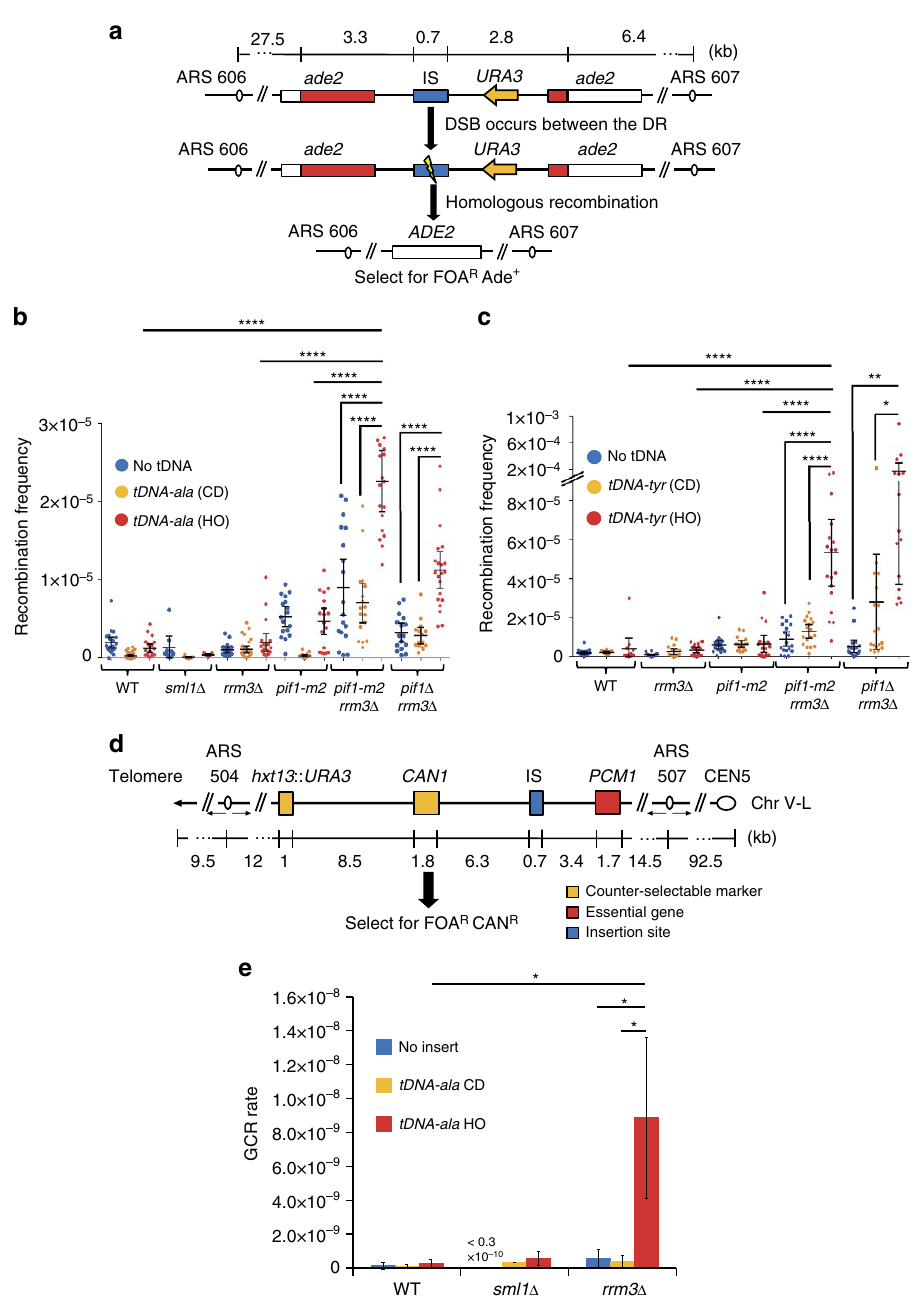
Figure 3 | Pif1 family DNA helicases suppress DSB-induced recombination at tDNAs. ( a ) Schematic of the direct repeat (DR) recombination construct generated on the right arm of chromosome VI. Blue box indicates site of tDNA insertions (IS) where tDNA ala or tDNA tyr was inserted in head-on (HO) or co-directional (CD) orientation. Different parts of ADE2 (red and white bars), neither of which is sufficient to generate Ade þ cells, are separated by B 5kb containing URA3. A double-strand break (DSB) between the ade2 segments initiates recombination between the two partial copies of ADE2 , which generates FOA R Ade þ cells. ( b , c ) Recombination frequencies in cells with no insert or containing tDNA ala ( b ) or tDNA tyr ( c ) in HO or CD orientations were determined by dividing the number of FOA R Ade þ cells by the number of viable cells that grew on non-selective plates. The means of the recombination frequencies with 95% confidence interval were calculated fromat least three independent technical and biological replicates per strain. The mean ± s.d. is also provided in Supplementary Tables 5 and 7. ( d ) Schematic of the left arm of chromosome V (Chr V-L) in gross chromosomal rearrangement (GCR) strains. tDNA ala HO or tDNA ala CD was inserted at insertion site (IS in blue box) in GCR strains. Genes within the 45kb test interval are non-essential; PCM1 (red box) is an essential gene, the most distal essential gene on ChrV-L. A DSB that occurs upstream of the two marker genes, URA3 and CAN1 (yellow boxes), initiates GCR events, which are monitored by selecting for FOA R Can R cells. ( e ) GCR rates with or without tDNA ala CD or HO inserts were calculated using FALCOR and MMS maximum likelihood method 64 . Means and standard deviations of GCR rates were obtained from at least three technical replicates of two different isolates per strain. Here, * indicates P o 0.05, ** indicates P p 0.009, and **** indicates P o